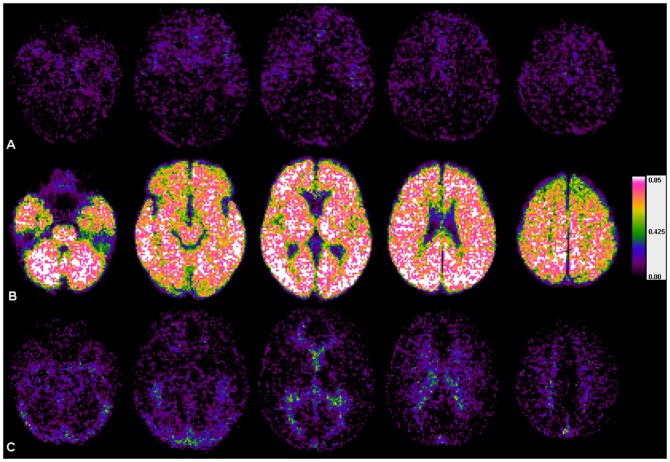
Cumulative vascularity maps (n = 7; TR = 1030 ms) of zf-intervals.
row A: Ιa = {v |−2≤zf(TTPv) <−1}, row B: Ιp = {v |−1≤zf(TTPv) ≤+1} and row C: Ιv = {v |+1 <zf(TTPv) ≤+2} (same as Fig. 2). Using the proposed zf-intervals, independently of the clearly longer TR, regions mainly containing arterial vessels (maps in row A), regions containing capillary and small cerebral vessels (maps in row B), and regions mainly containing veins and sinuses (maps in row C), could be readily distinguished from each other. (Note that due to the smaller number of patients in this group the maps appear less homogeneous and more noisy than those in Fig. 2.)